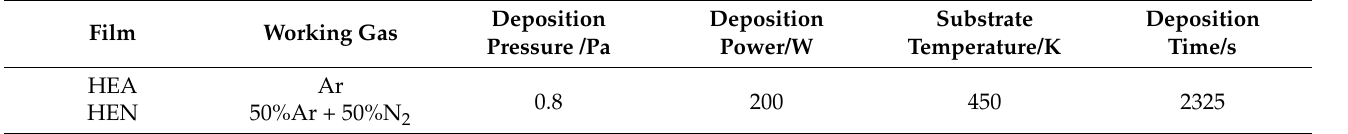
Table 3. Details of deposition